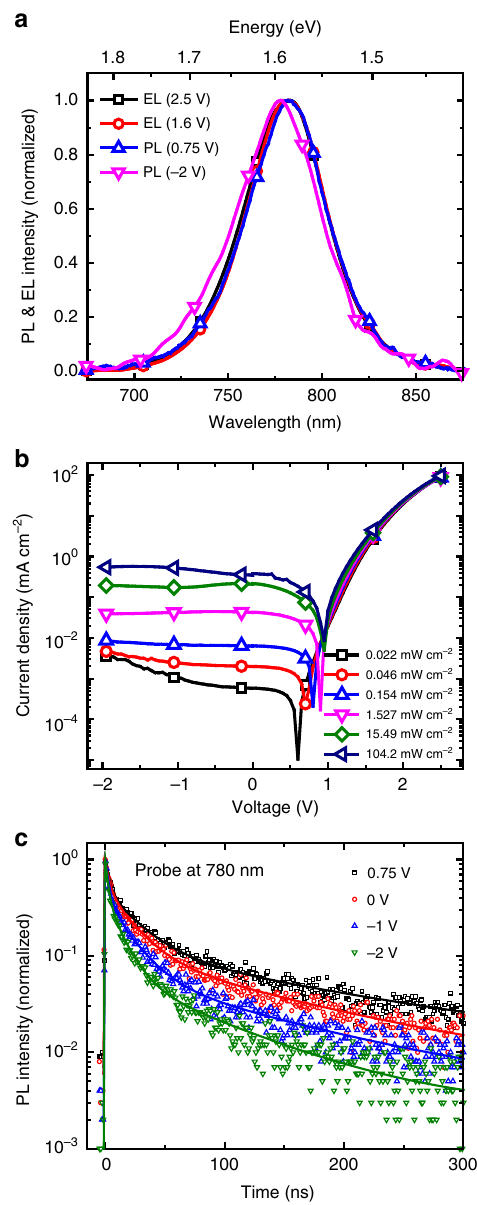
Fig. 2 Electrical fi eld-dependent characteristics of perovskite MQW LEDs. a Normalized EL and PL spectra of the device under various bias voltages. EL (2.5 V, black square, 1.6 V, red circle), PL (0.75 V, blue triangle, − 2 V, magenta triangle). b Dependence of current density on the driving voltage under various illumination intensities. c Time-resolved PL decay